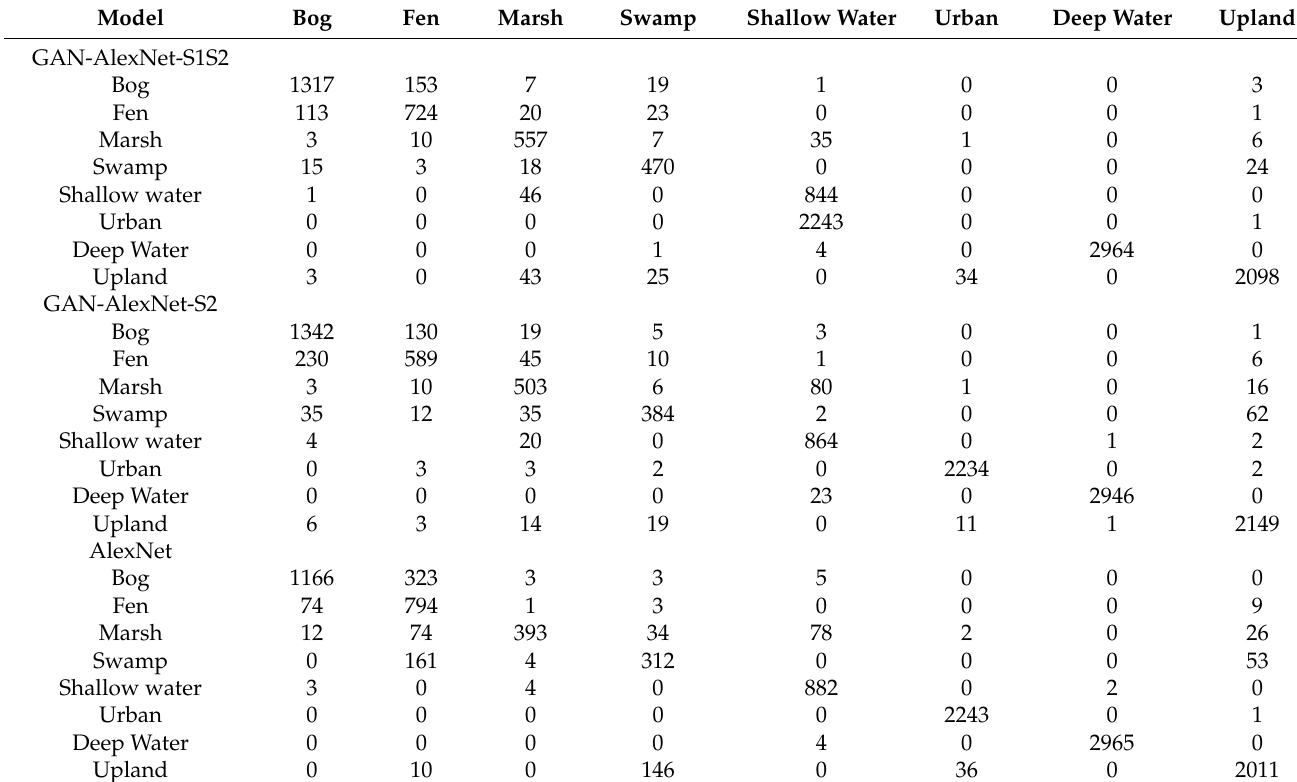
Table 5. The confusion matrices of the proposed DCNN model and the AlexNet classifier (S1 = Sentinel-1, S2 = Sentinel-2). Model Bog Fen